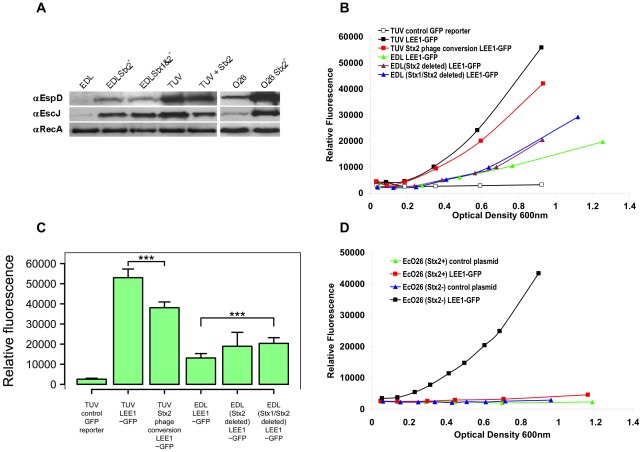
Analysis of T3S and LEE1 expression in E. coli with and without integrated Stx prophages.(A) Western blot analysis of paired E. coli O157 and O26 strains. EspD was detected from bacterial supernatants and EscJ and RecA from whole cell samples prepared as described in Materials and Methods. EDL is the sequenced EDL933 strain and this was originally compared with a published strain TUV93-0 (lane 4) that has lost both Stx1- and Stx2-encoding prophages. This strain demonstrates higher secretion levels and EscJ expression. The Stx2-encoding prophage and the Stx1-encoding prophage were deleted from EDL933 (lanes 2 and 3 respectively) leading to increased T3S. A marked Stx2 phage [67] was conjugated into TUV93-0 expressing a cloned cI from Sakai Sp5 (lane 5) and this resulted in a reduction in T3S and EscJ expression. The final two lanes contain samples from a published isogenic pair of EHEC O26 strains [47] from which one has lost the Stx2 phage leading to a marked increase in T3S. (B–C) To quantify differences in T3S expression, the same strain sets as in part A, were transformed with a LEE1-GFP construct and fluorescence measured throughout the growth curve. This was repeated three times with one experiment shown in (B). A minimum of three values were determined from the expression curves for OD600 = 0.9 and plotted in (C) as mean and 95% confidence intervals. *** : p<0.001 for the TUV strains and p = 0.001 for the EDL strains compared. (D) The E. coli O26 pair of strains blotted in (A) (table 1) were transformed with the LEE1-GFP expression construct or a control plasmid and population fluorescence levels measured through the growth curve. Taken together the data demonstrates that lysogeny with an Stx2-encoding phage represses T3S expression.